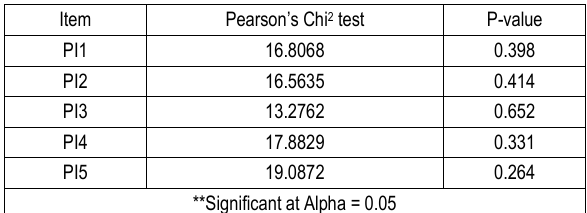
Table 11. Association between education